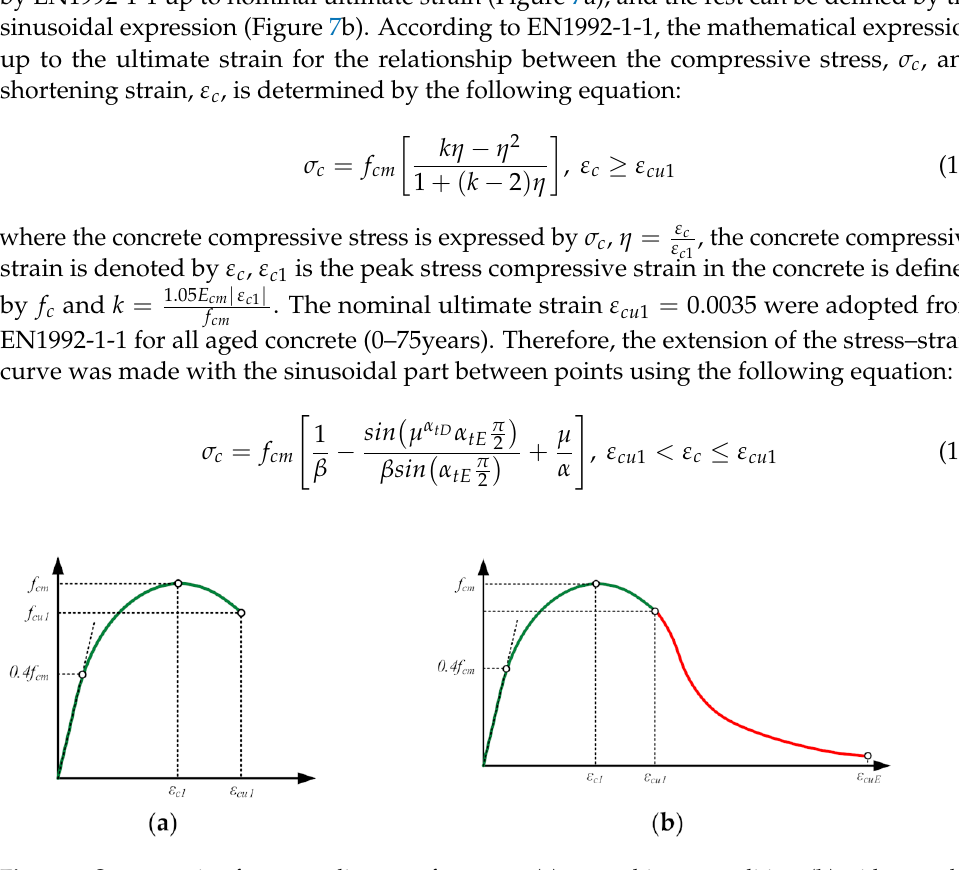
Figure 7. Stress–strain of concrete diagram of concrete: ( a ) up to ultimate condition; ( b ) with extended sinusoidal